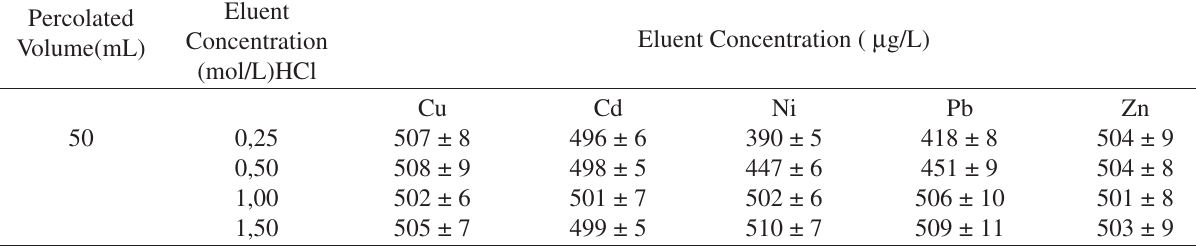
Table 2. Preconcentration factor of Cu(II), Ni(II), Zn(II), Cd(II) and Pb(II) obtained using a column packed with Cell-PAB. Experimental Conditions: Metal Ions Concentration = 50 µ g/L of Cu(II), Ni(II), Zn(II), Cd(II) and Pb(II); Preconcentrated volume = 50 mL; Eluent – 5 mL of HCl solutions in different concentration; Flow Rate – 1.0 mL/min.